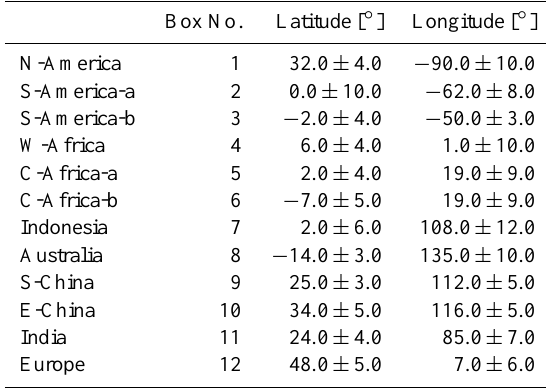
Table 4. Regions selected for Fig. 9. Box